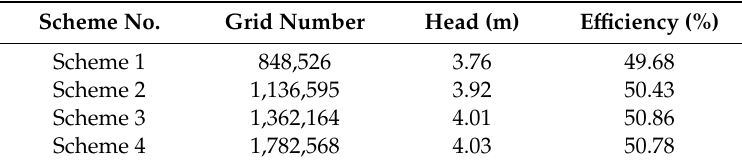
Table 4. Grid independence